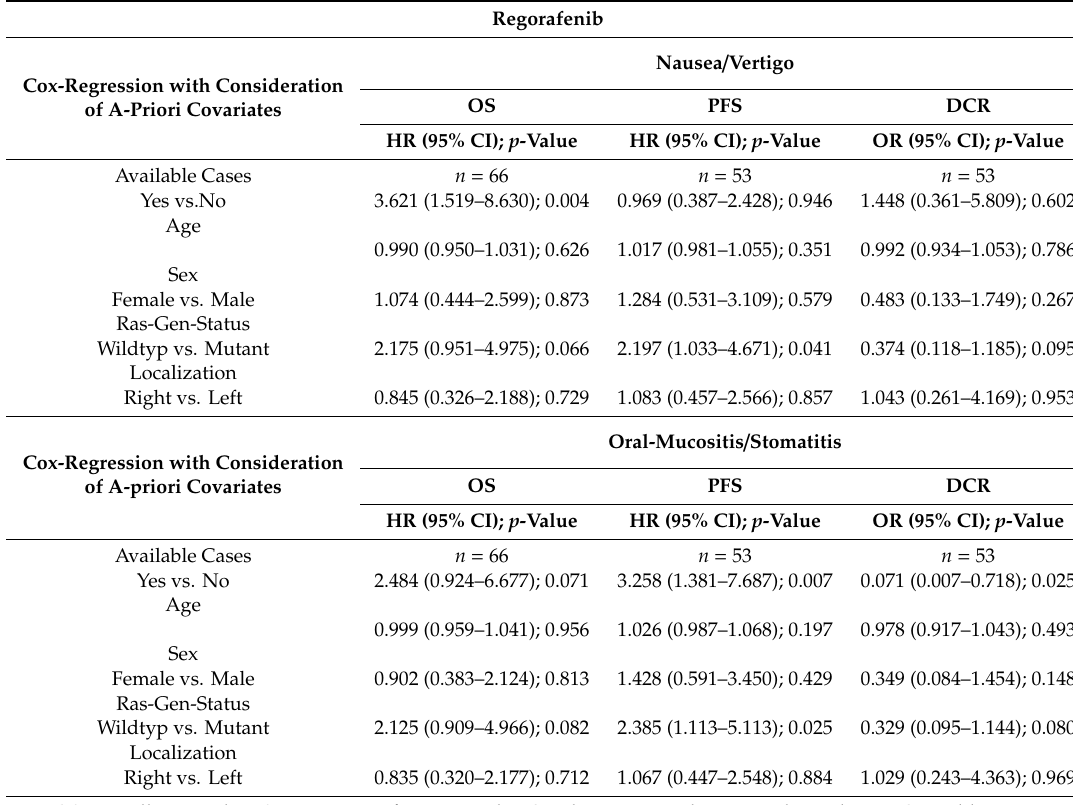
Table 2. Association between progression-free survival (PFS) / overall survival (OS) / disease control rate (DCR) and adverse events with consideration of a-priori covariates in regorafenib.